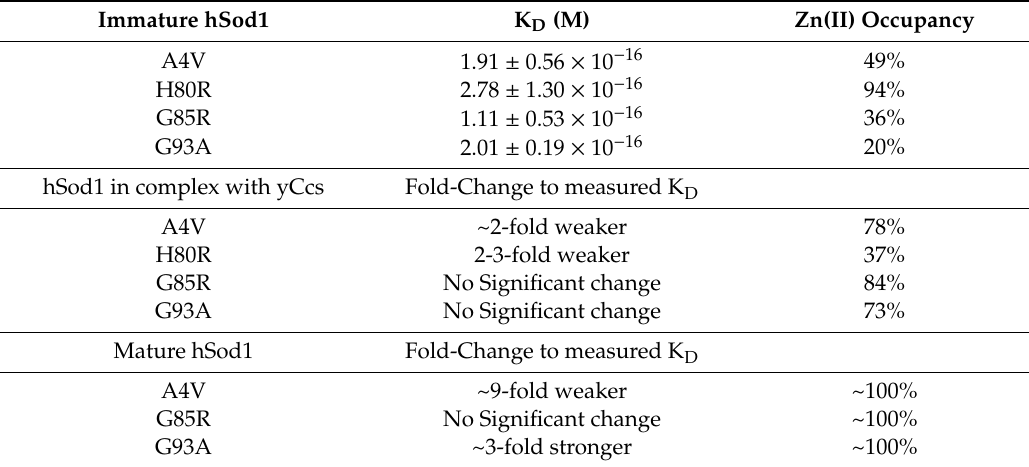
Table 1. Zn(II) dissociation constants and occupancies for fALS-Sod1